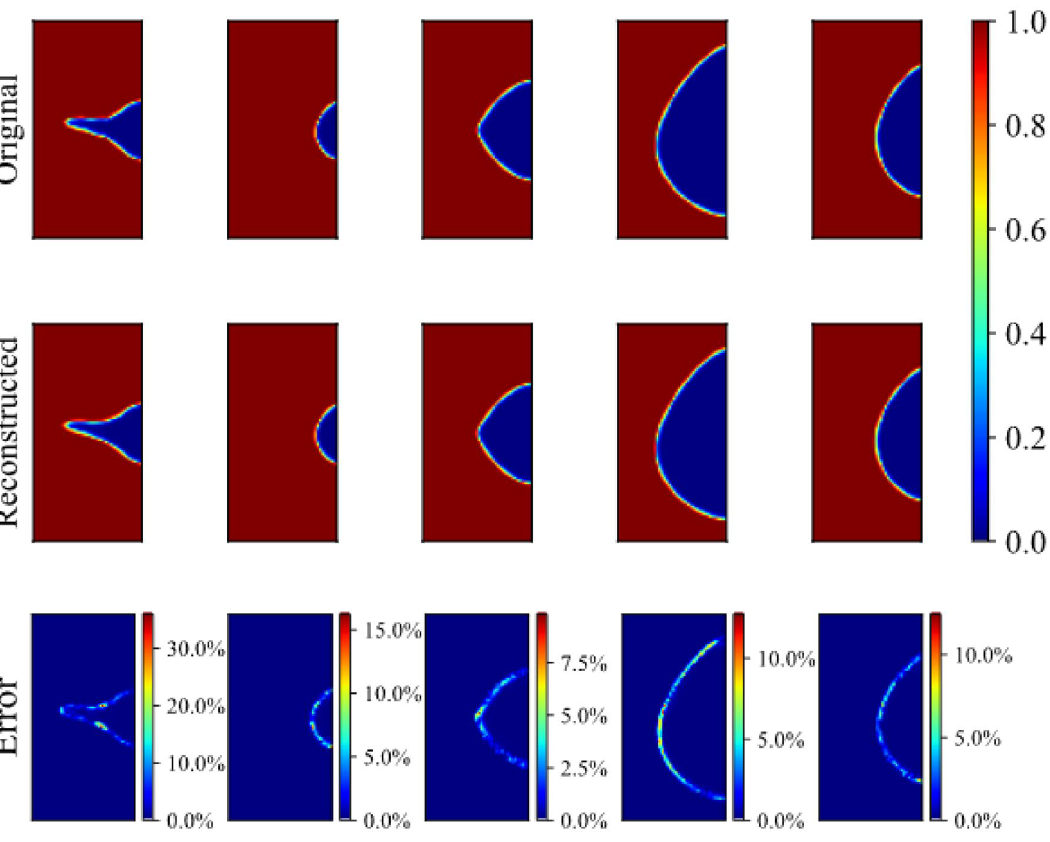
Figure 14. Comparison and error of reconstructed figure from latent